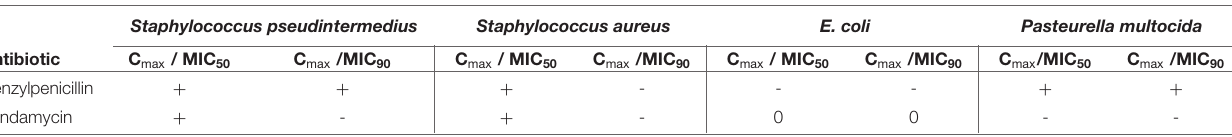
TABLE 7 | PK-PD-Target attainment for various antibiotics and different pathogens in cats. Staphylococcus pseudintermedius